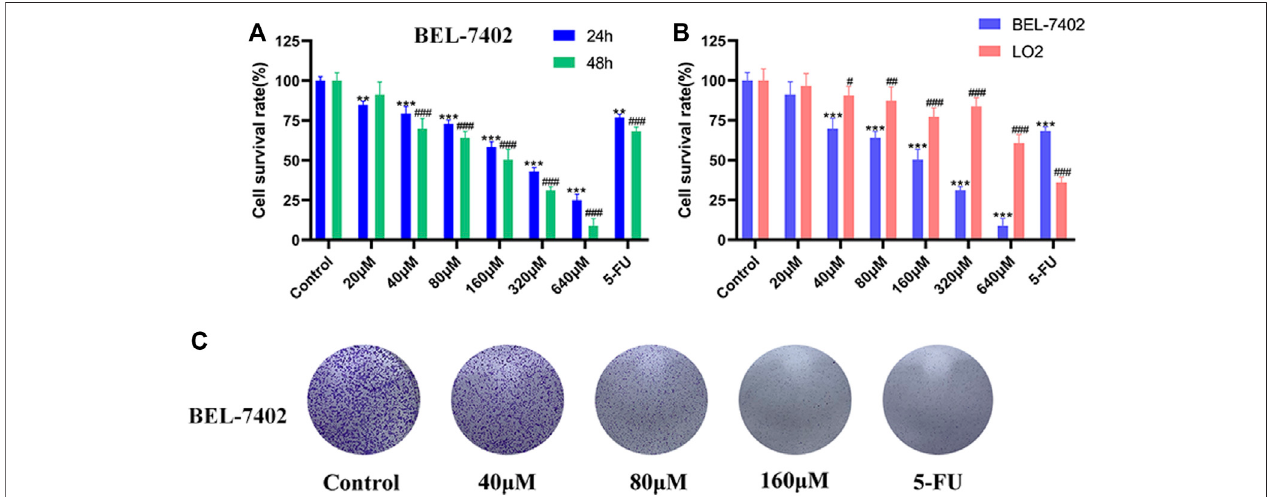
FIGURE 1 | Effect of methyl gallate (MG) on cell viability. (A) BEL-7402 cells were treated with MG and 5-FU for 24 and 48 h (B) BEL-7402 and LO2 cells were treatedwithMGand5-FUfor48 h. (C) TheeffectofMGoncolonyformationinBEL-7402cellsafter2 weeksofdrugadministration.Datawerederivedfromatleastthree independent experiments. Data are presented as the mean ± standard deviation. *, # p < 0.05, **, ## p < 0.01 and ***, ### p < 0.001 vs. control.